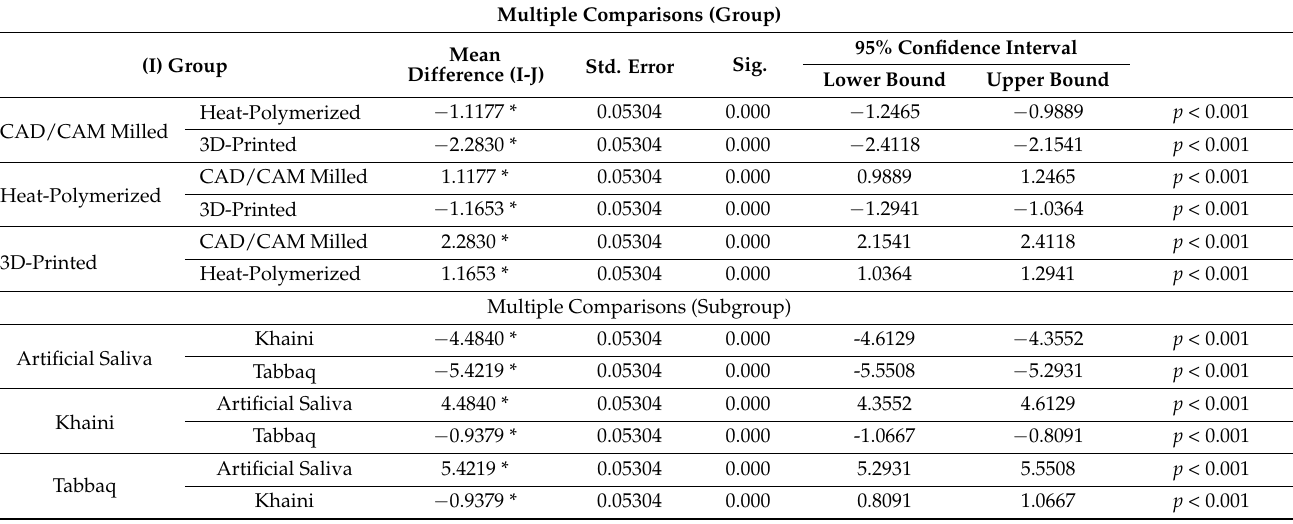
Based on observed means. The error term is mean square (error) = 0.059. * The mean difference is significant at the 0.05